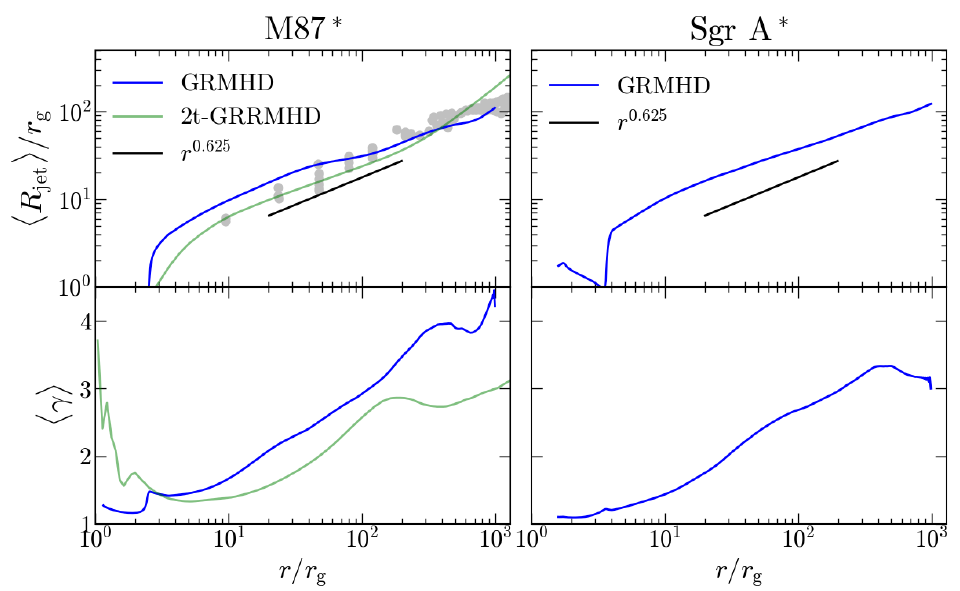
Figure 5. We show the jet radius R jet and the jet Lorentz factor γ from the M87 ∗ GRMHD and 2t-GRRMHD models, and the Sgr A ∗ GRMHD model. The gray circles indicates the deprojected jet radius of the M87 jet assuming a BH mass of 6.2 × 10 9 M (cid:12) and a source inclination of 14 ◦ [70]. The data points are a compilation of various papers